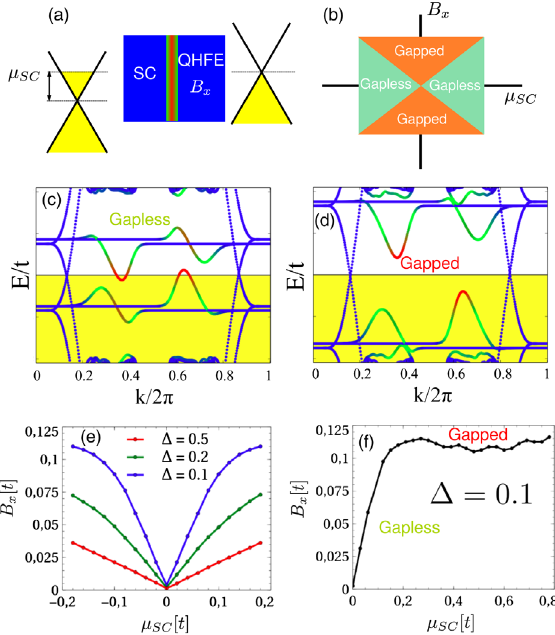
FIG. 7. (a) Scheme of the effect of chemical doping in the Dirac spectrum of proximized graphene. (b) Schematic phase diagram of the interface electronic spectrum between the SC and the QH ferromagnet, as a function of the in-plane field and the chemical doping of the SC. Quasiparticle energies for a gapless (c) and gapped (d) interface. Phase boundary obtained by numerical calculation at low dopings (e) and at large doping (f). The green and red colored states of the band structures correspond to the states localized at the interface, where the topological super- conducting gap is calculated between the red states shown in (c,d). The blue gapless states correspond to the chiral states between the QH and